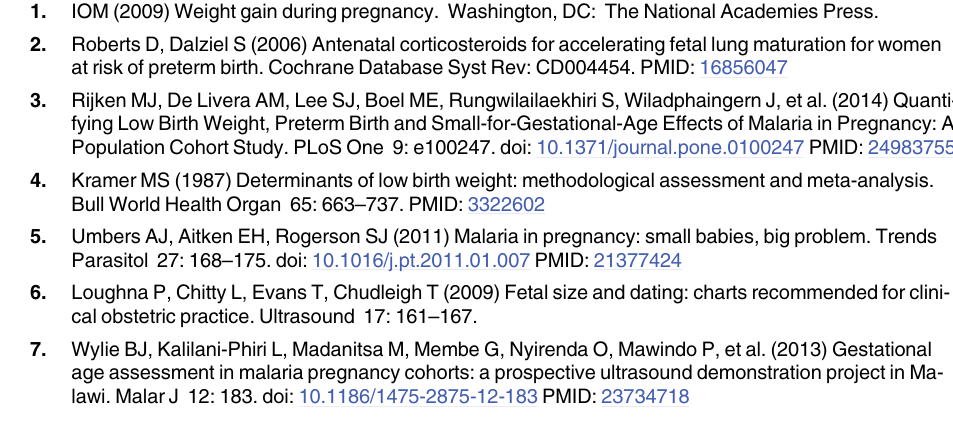
S3 Fig. LMP/SFH Model Developed in the Present Study. Panel A shows a histogram of the distribution of GA estimates by the novel model. Panel B shows the Bland-Altman plot show- ing mean bias and confidence levels of agreement between the new model and the reference ul- trasound. Panel C shows the concordance plot with the orthogonal regression line. (TIF) S4 Fig. Ballard Scores (total BS) Stratified by Assessor. Panel A: Gestational Age by total BS; Panel B: Bias between reference early pregnancy ultrasound and total BS by assessor. Only data for assessors with more than 20 measurements is shown. The red box-and-whiskers chart on the left represents the entire study population. Bias estimates for some assessors deviated sig- nificantly from the population median (Mann-Whitney Test) indicating variable performance of the assessors. (TIF) S1 Table. Linear regression parameters for average GA vs bias from the Bland-Altman anal-